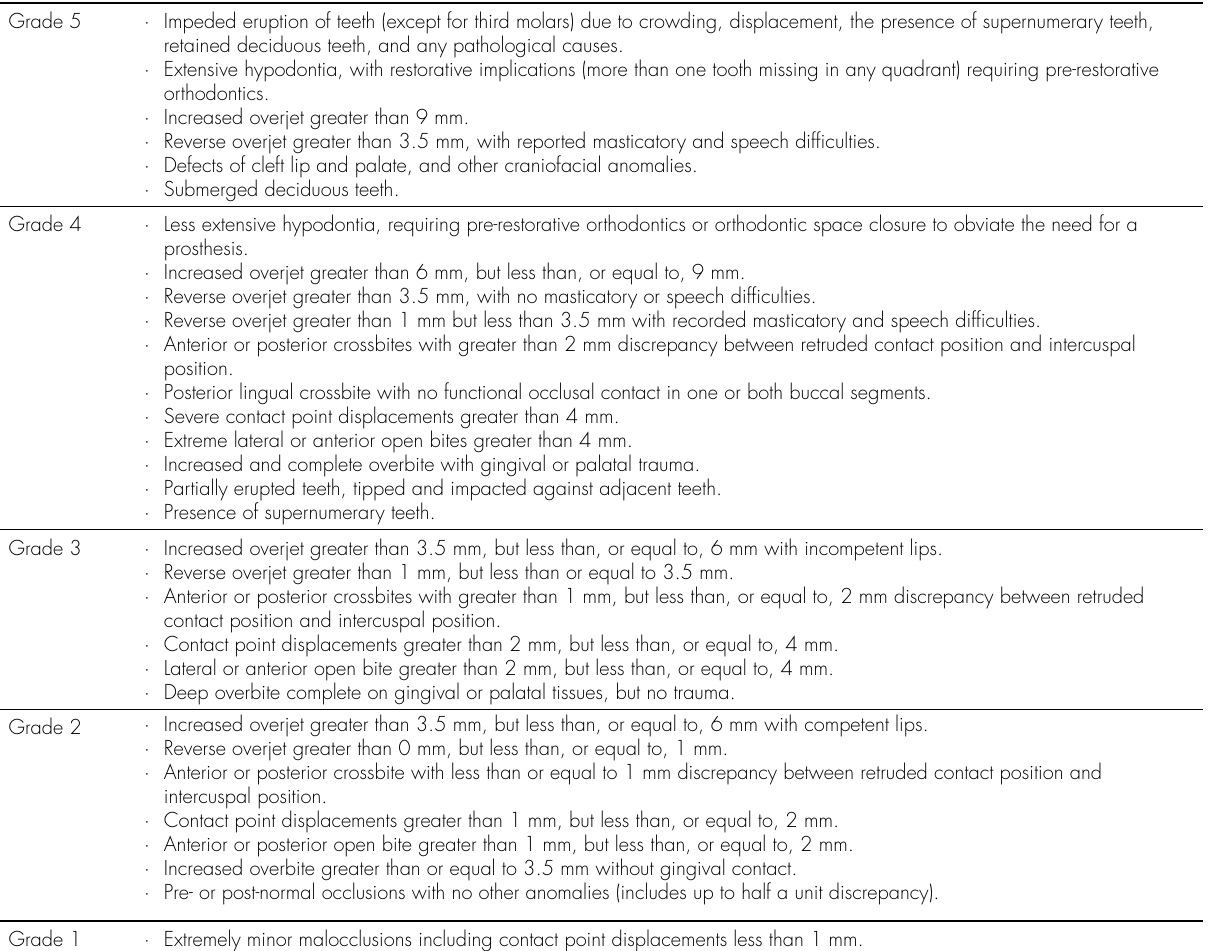
Table I. IOTN Dental Health